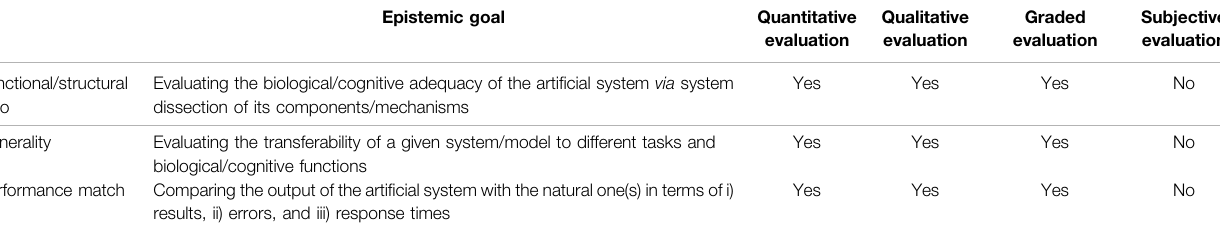
TABLE 1 | The three dimensions of the Minimal Cognitive Grid individually analyzed with respect to their epistemic goal and the types of allowed evaluations. Epistemic